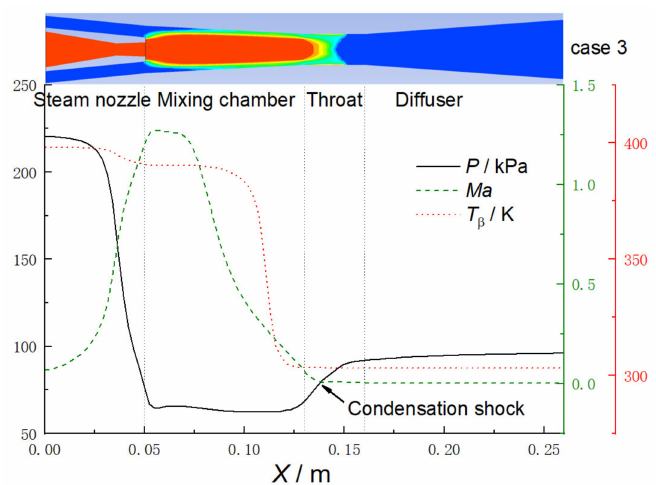
Figure 5. Axial profiles of static pressure, Mach number, and temperature for case 3.